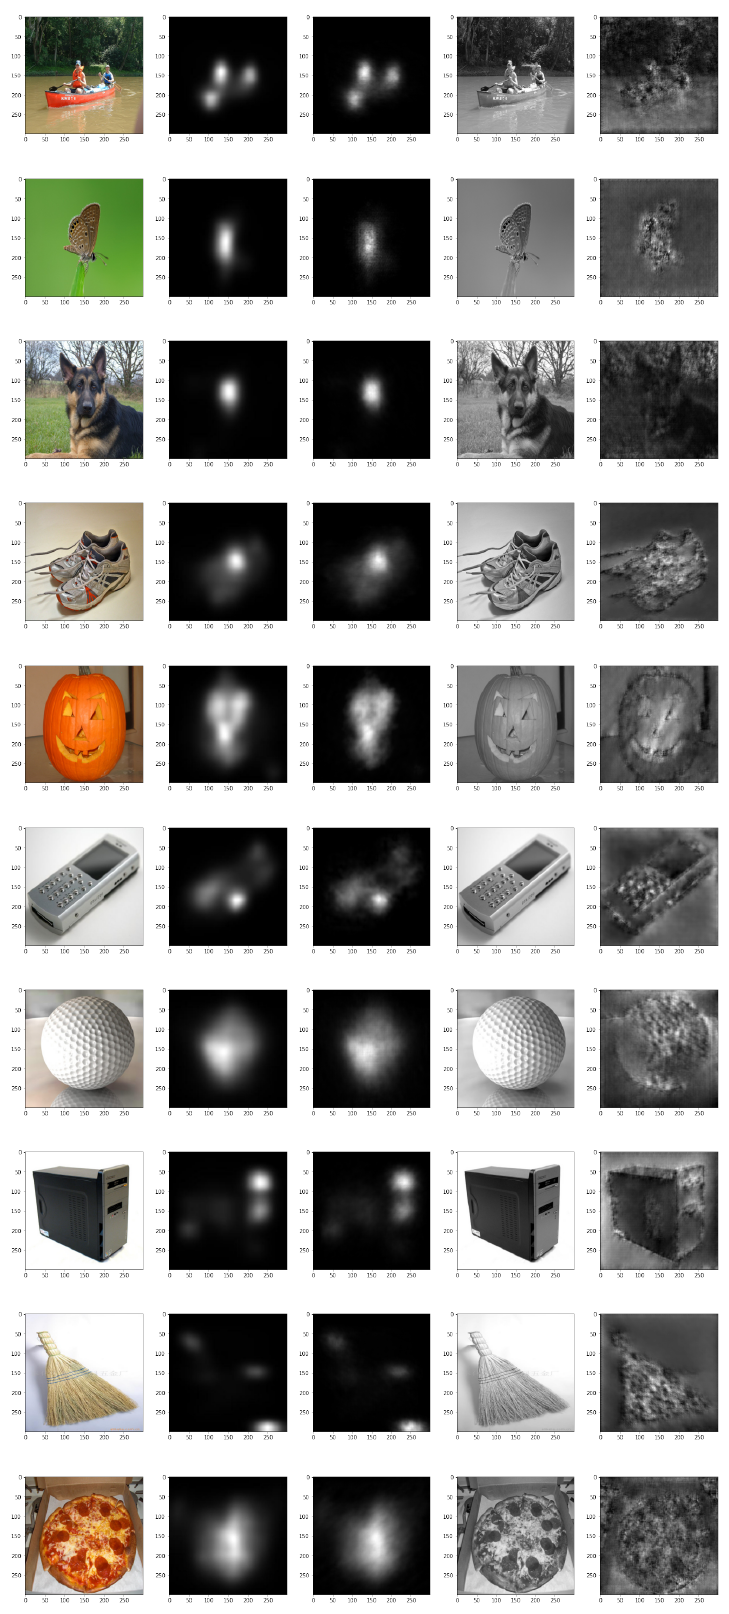
Figure 17. Reconstructed saliency and gray-scale images for categories 11–20; from ( left ) to ( right ): image used as stimulation, fixation map, EEG-based reconstructed saliency map, gray-scale image, EEG-based reconstructed gray-scale